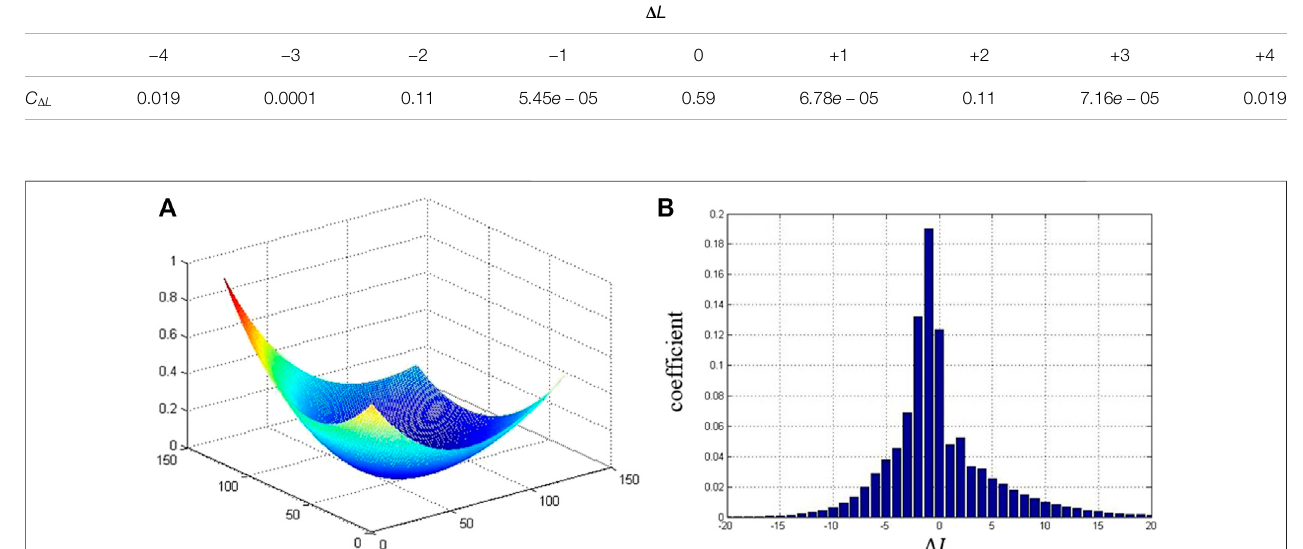
TABLE 2 | Coef fi cients of spiral spectrum modes for two off-axis Gaussian vortex structures. − 4